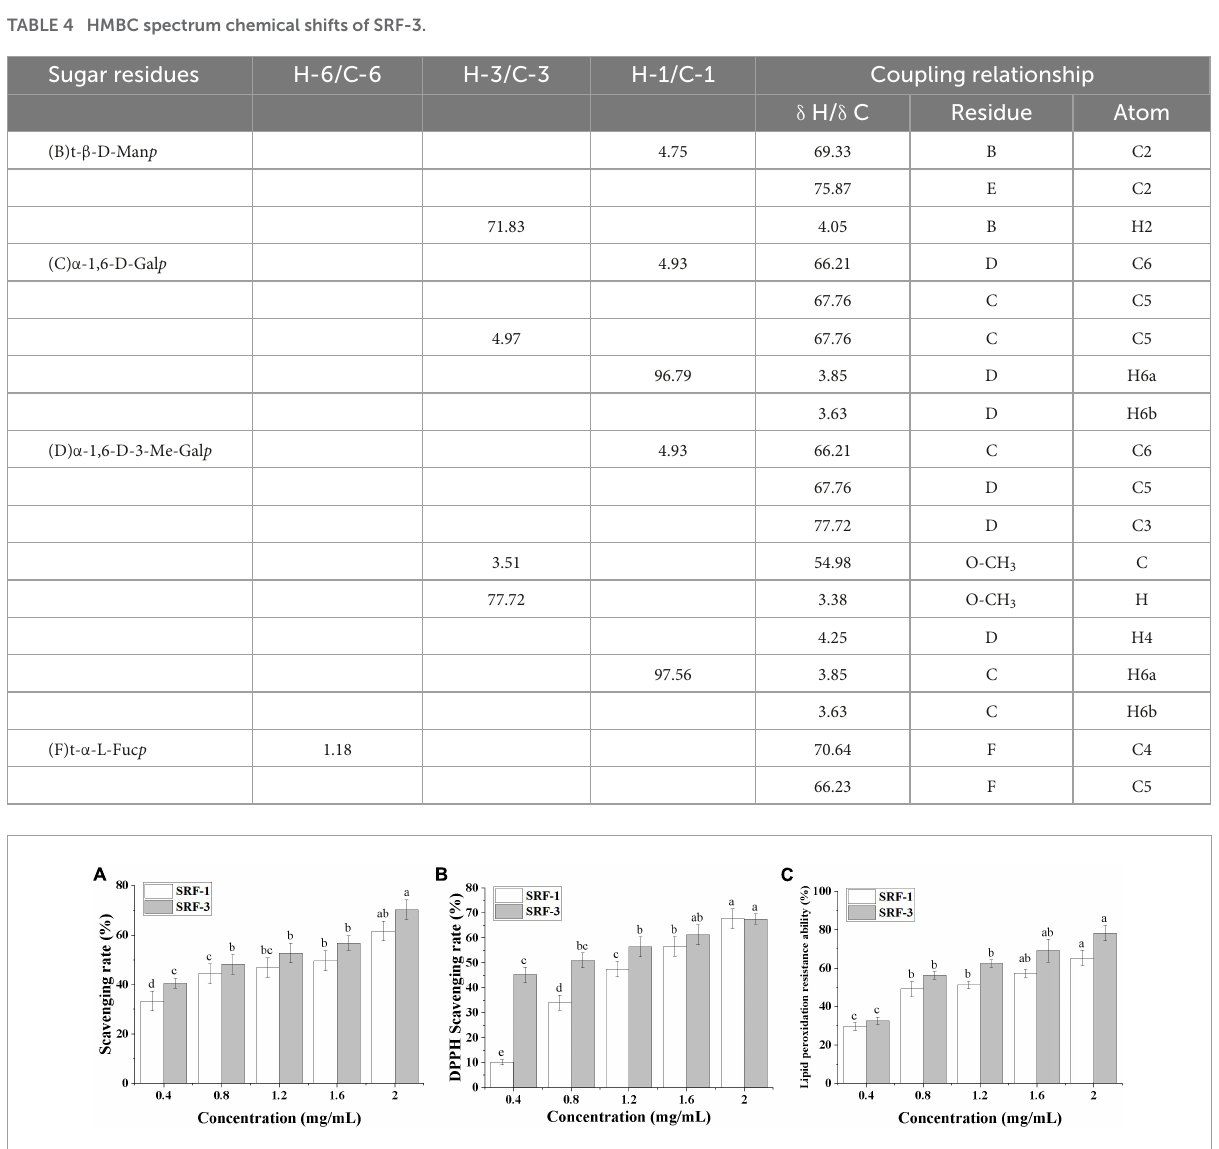
FIGURE8 In vitro determination of the antioxidant capacity. (A) Hydroxyl radical scavenging capacity. (B) DPPH scavenging capacity. (C) Lipid peroxidation resistance capacity. Values with different letters (a–d) were significantly different ( p < 0.05).